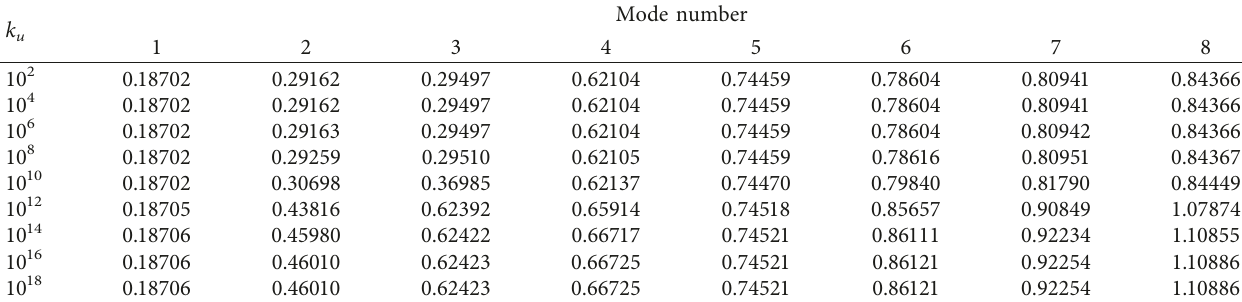
Table 3: Comparison of the frequency parameters Ω of an orthotropic plate elastically restrained in the y